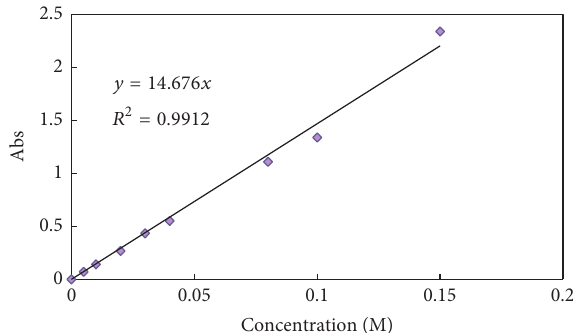
Figure 3: Calibration curve of VOSO 4 solution with the concentra- tion range between 0.005 M and